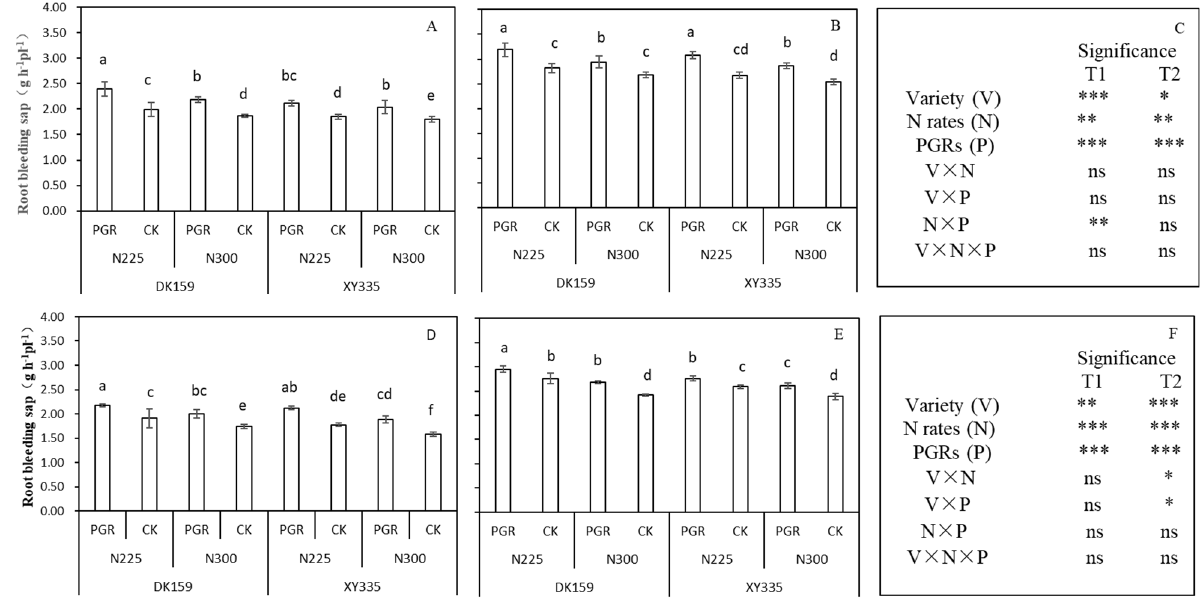
Figure 3. Effects of PGRs and nitrogen fertilizer on root bleeding sap at 10 days after silking ( A , D ) and 30 days after silking ( B , E ) in 2019 and 2020. Effects of Variety (V), N rates (N), PGRs (P), and their interaction effects in 2019 ( C ) and 2020 ( F ) were listed (T1 represents 10 days after silking; T2 represents 30 days after silking). The vertical bars denote the mean ± the standard error of the mean; ns means non-significant; *, **, and *** indicate significance at p < 0.05, < 0.01 and < 0.001 probability levels, respectively. Different lowercase letters represent significant differences among treatments ( p <